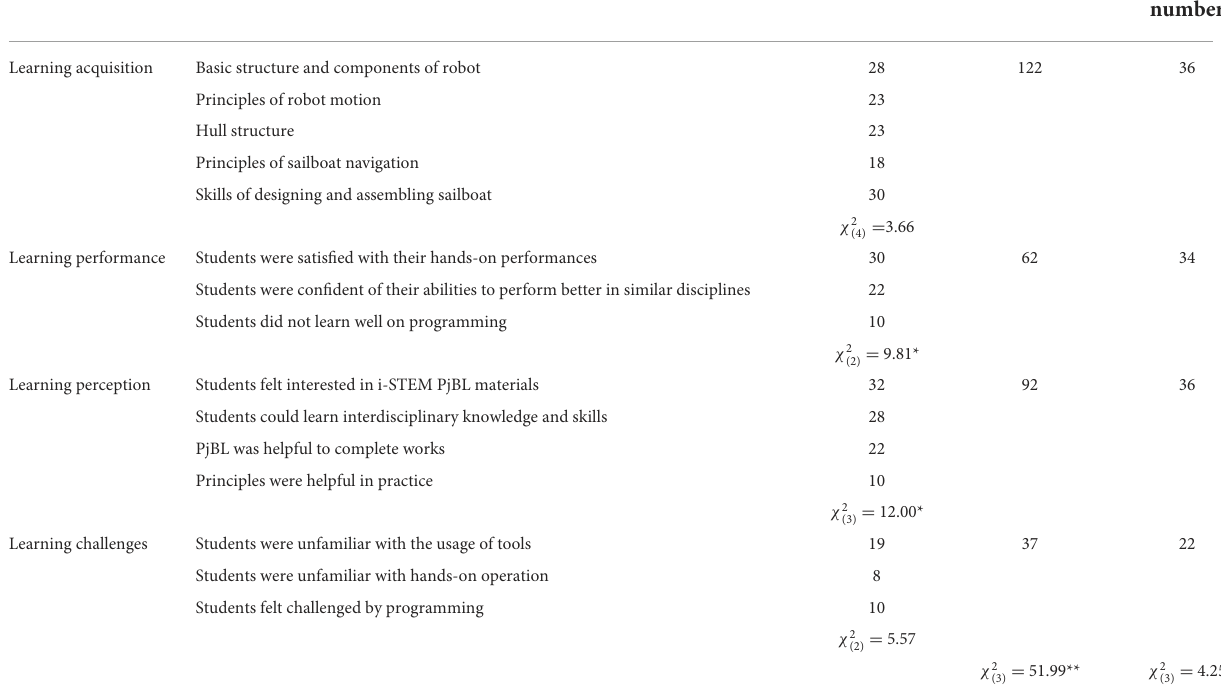
TABLE 2 The number of times each coding appeared and test of goodness-of-fit ( N = 40). Main